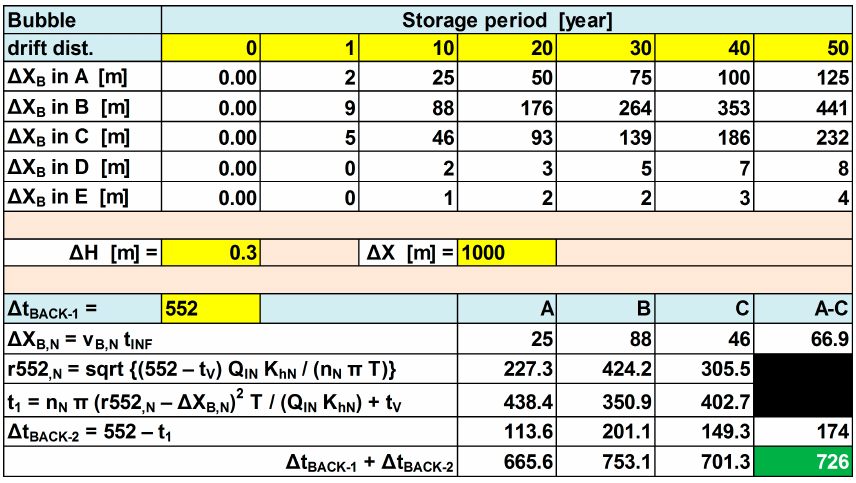
Figure 8. Calculated horizontal bubble drift ( Δ X B ) as function of aquifer layer and storage time, for the Liwa aquifer system, and its impact on the set-back time Δ t BACK-2 . Together with the set-back time due to recovery ( Δ t BACK-1 ), a total set-back time of 726 d is obtained. Further explanation can be found in the text and in the list of abbreviations (end of paper).